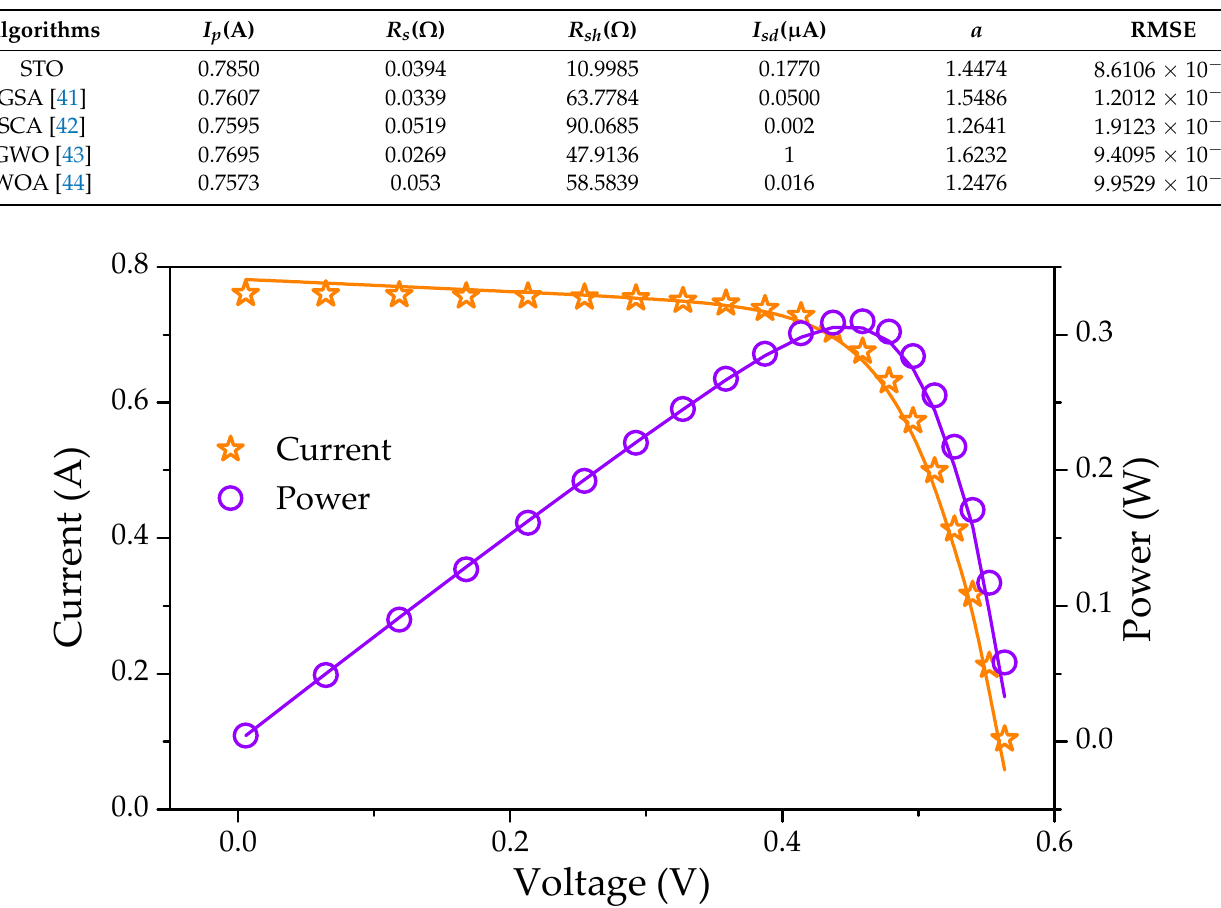
Table 4. The simulated current and absolute error results of the STO for SDM of the SS2018 PV module.